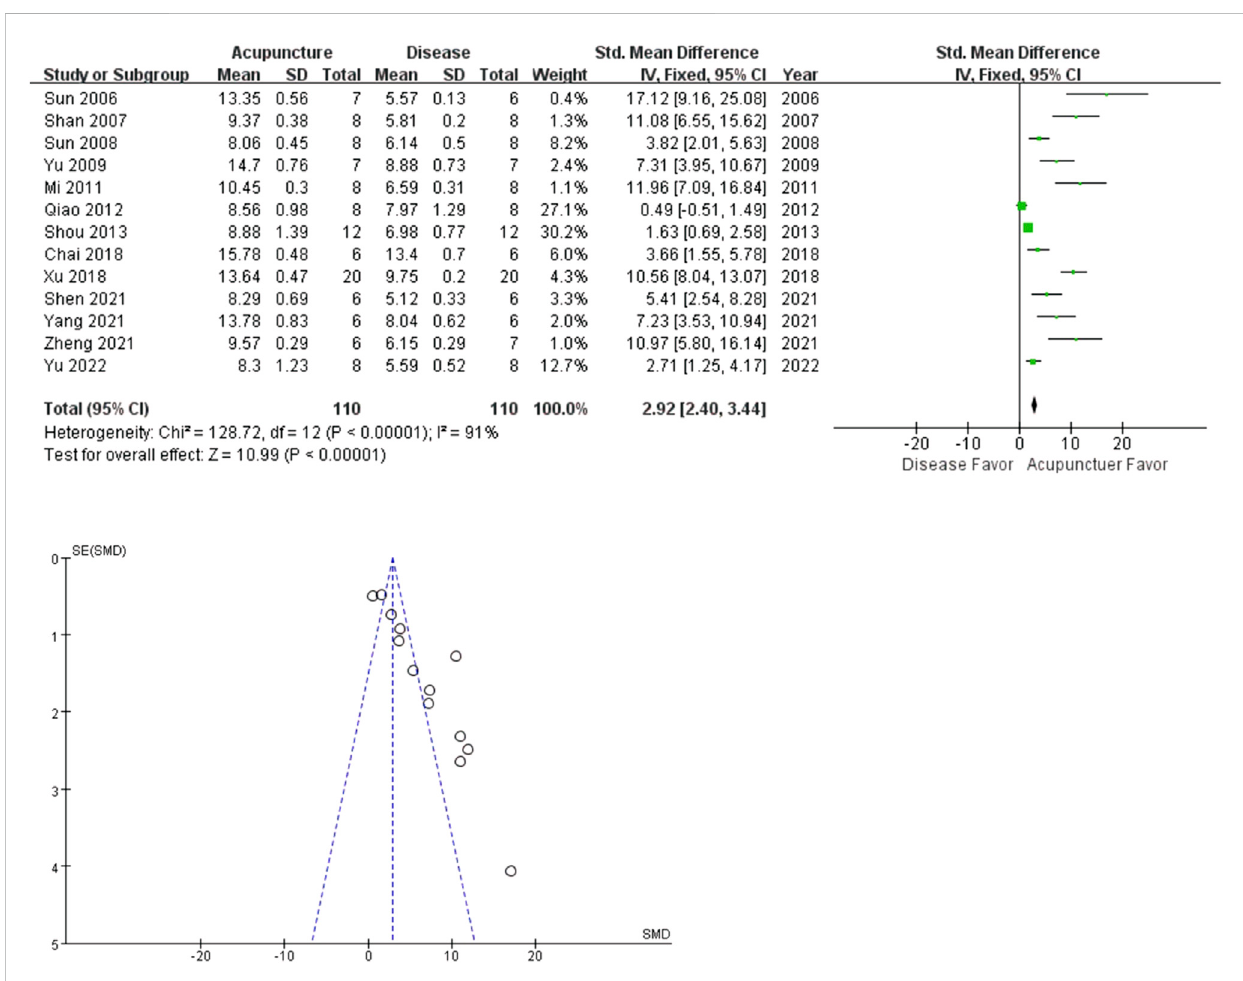
FIGURE 3 Meta-analysis comparing PWLs between the disease group and the acupuncture-treated